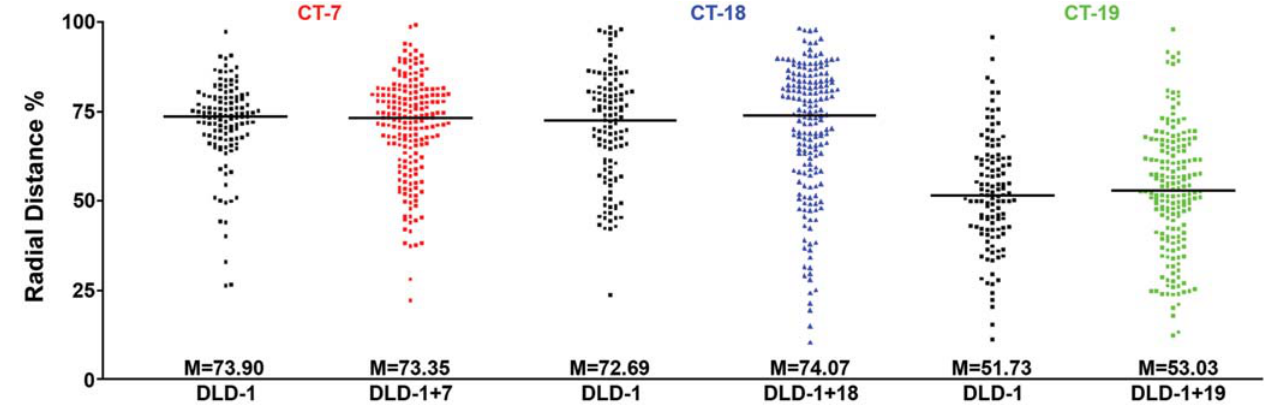
Figure 5. Raw distributions of 3D-distance measurements. CT-7 in DLD-1 & DLD-1 + 7, CT-18 in DLD-1 & DLD-1 + 18, CT-19 in DLD-1 & DLD-1 + 19. X-axis: cell line, Y-axis: Normalized radial distance (%) of chromosome territories from the geometric center of the nucleus.